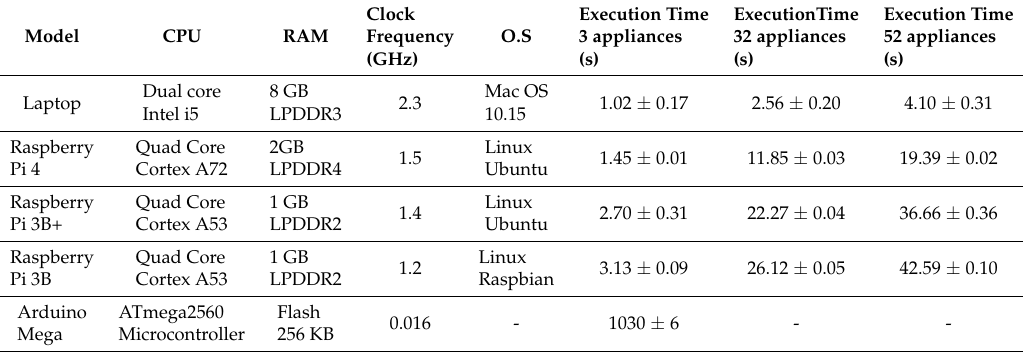
Table 2. Computational cost (an average) measured on different